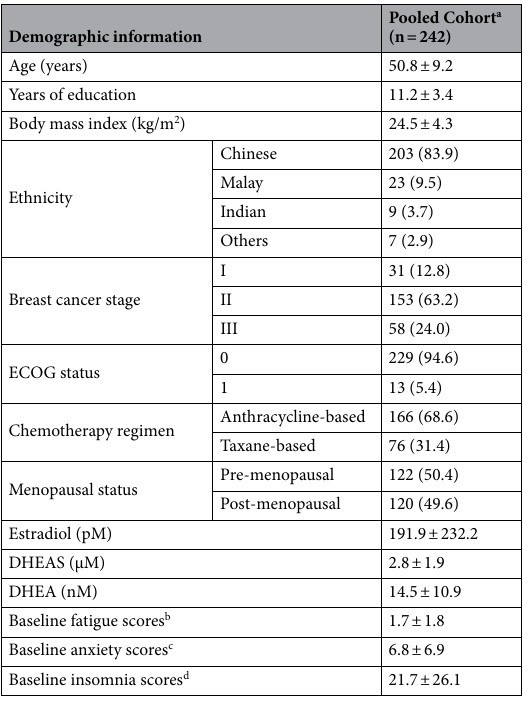
Table 1. Baseline demographic and clinical characteristics of the patients. a Data are presented as mean ± standard deviation for continuous variables and frequency (%) for categorical variables. b Fatigue scores are out of maximum of 10 points, with higher score indicating greater extent of fatigue. c Anxiety scores are out of maximum of 63 points, with higher score indicating greater extent of anxiety. d Insomnia scores are out of maximum of 100 points, with higher score indicating greater extent of insomnia.